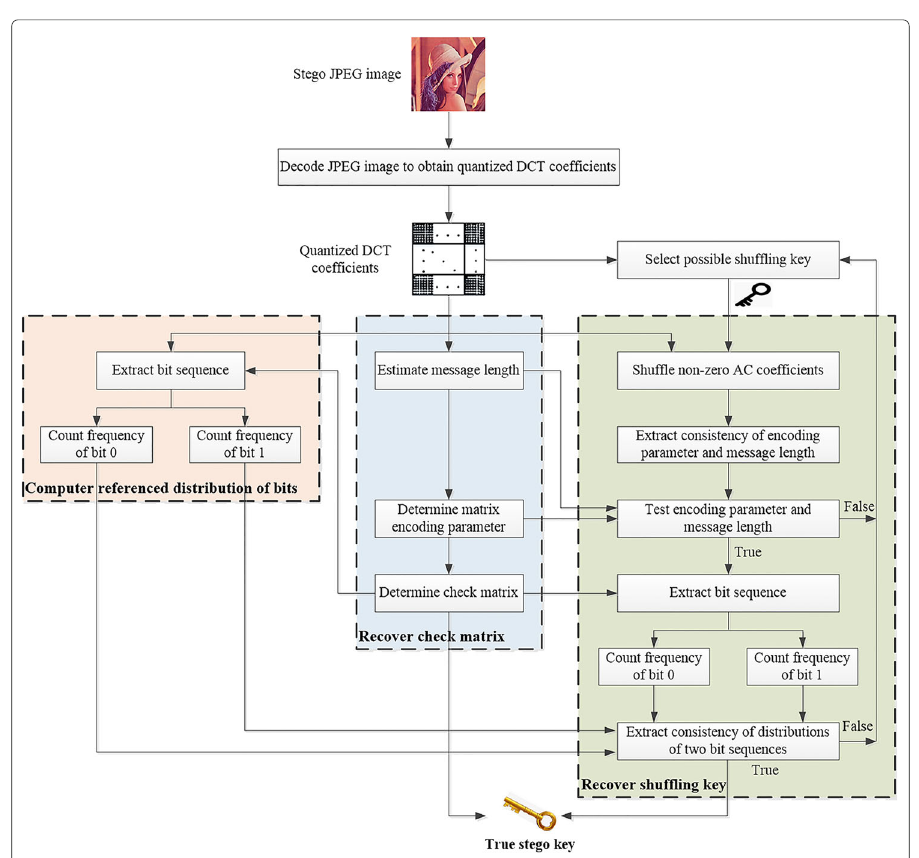
Fig. 4 Diagram of the proposed stego key recovery